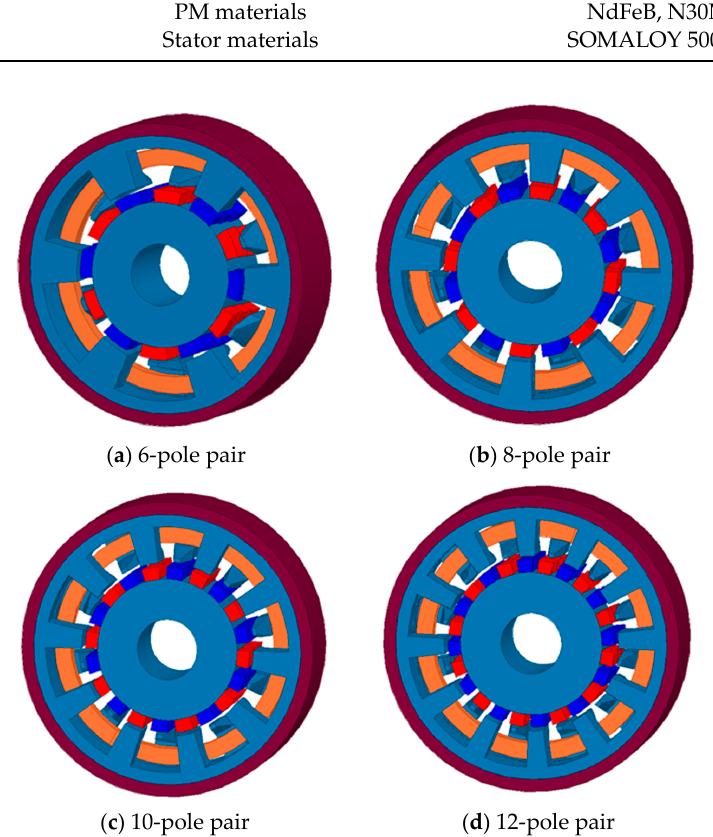
Figure 2. Machine topology of a claw pole machine with different numbers of pole pairs.